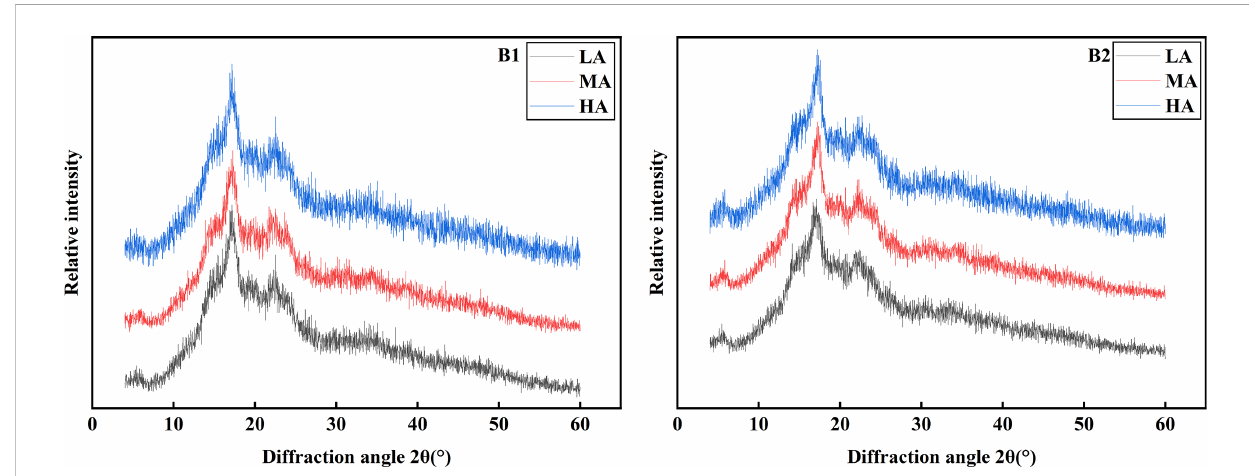
FIGURE 8 XRD patterns of potato starch at different altitudes. LA (low altitude), MA (middle altitude) and HA (high altitude) stand for Chongzhou, Xichang and Litang respectively; B1 and B2 stand for Jiusen No. 1 and Qingshu No. 9